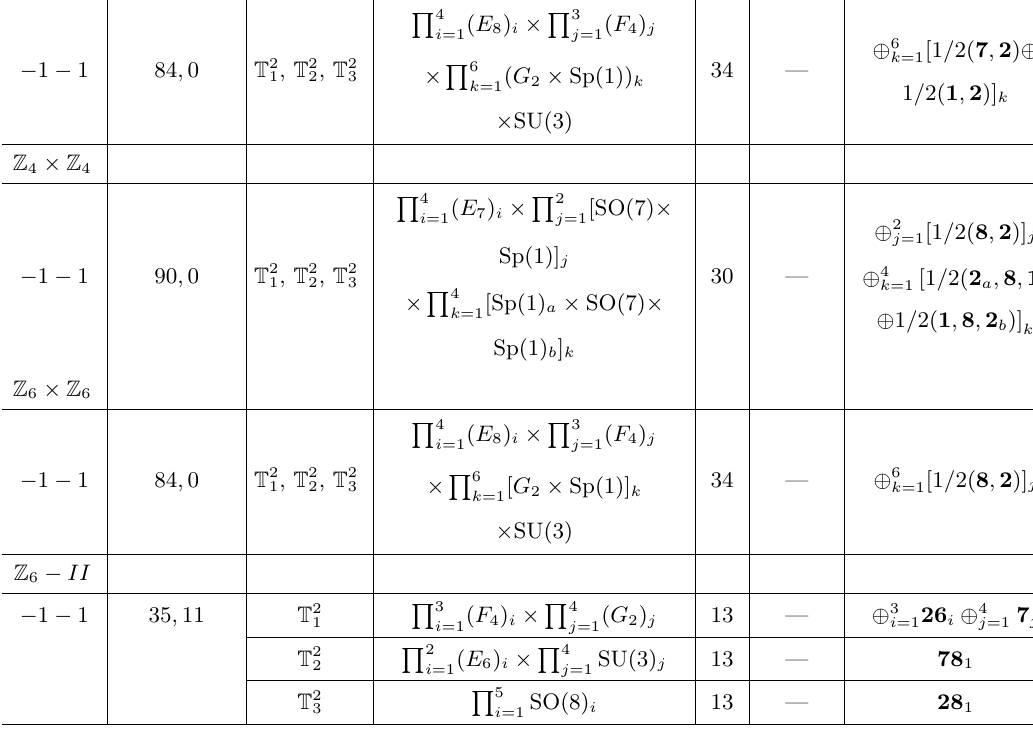
Table 2. This table summarizes the massless matter content of F-theory compactifications of the various STOs. The first two columns show the STO class and their Hodge-numbers. The four columns to the right provide for the specified choices of F-theory fibre, the gauge groups of the theory G ( ? denotes no gauge group), the number of tensor multiplets T as well as the representations of the charged hyper multiplets at the tensor branch. When multiple fibers are present we highlight the (2 , 0) tensors in the sixth column. The sub index of the representation specifies the factor of G under which the multiplets are charged, i.e. if G = G 1 × G 2 , then R 1 means ( R , 1 ) . We also do not depict possible discrete gauge